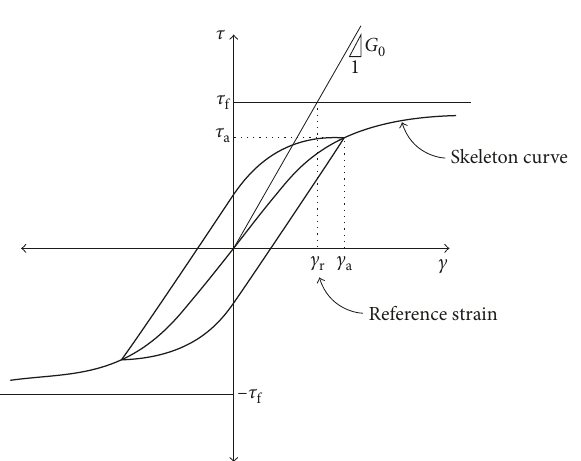
Figure 5: Definition of reference strain (adapted from